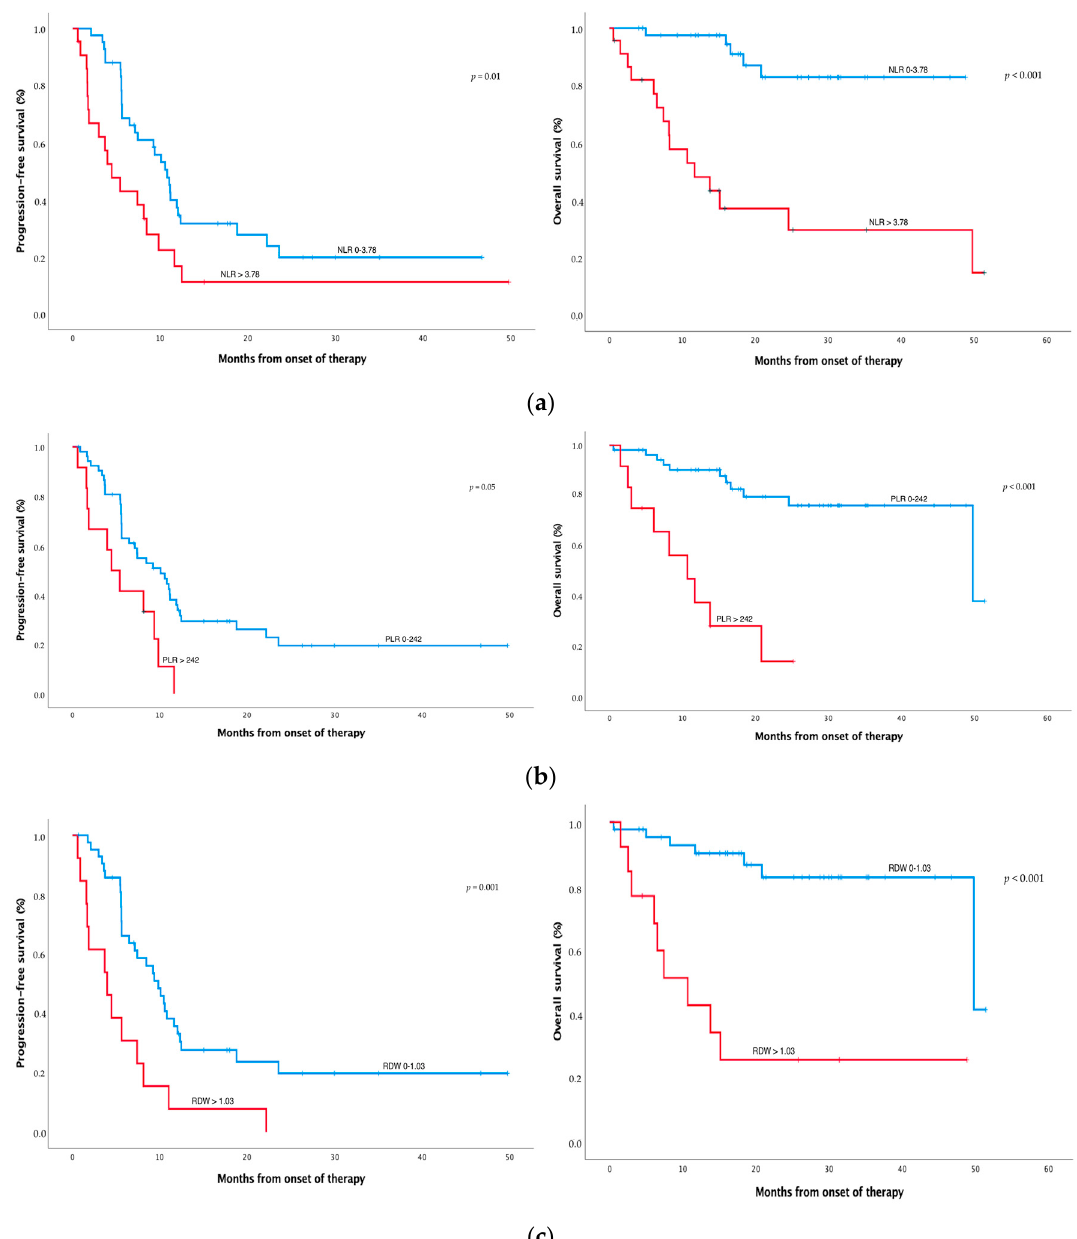
Figure 1. Survival analysis of SFT treated with pazopanib. Progression-free survival (PFS) and overall survival (OS), according to Choi criteria, of SFT patients with high NLR (>3.78) vs. low NLR ( a ), high PLR (>242) vs. low PLR ( b ), and high RDW (>1.03) vs. low ( c ). NLR, PLR, and RDW were measured before pazopanib treatment. The optimal cut-off point to categorise patients between high and low levels of each inflammatory index was calculated by the maxstat package. Significance between groups was defined at p -values <